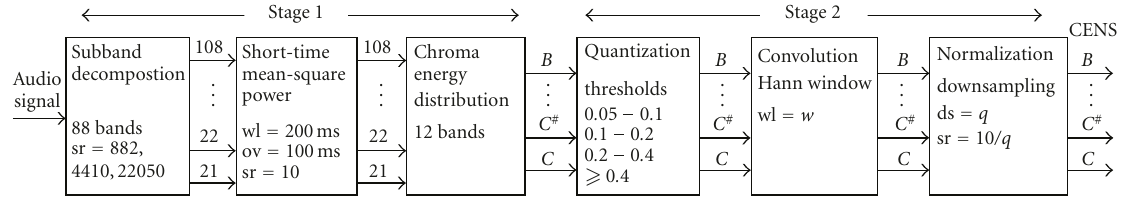
Figure 3: Two-stage CENS feature design (wl = window length, ov = overlap, sr = sampling rate, ds = downsampling